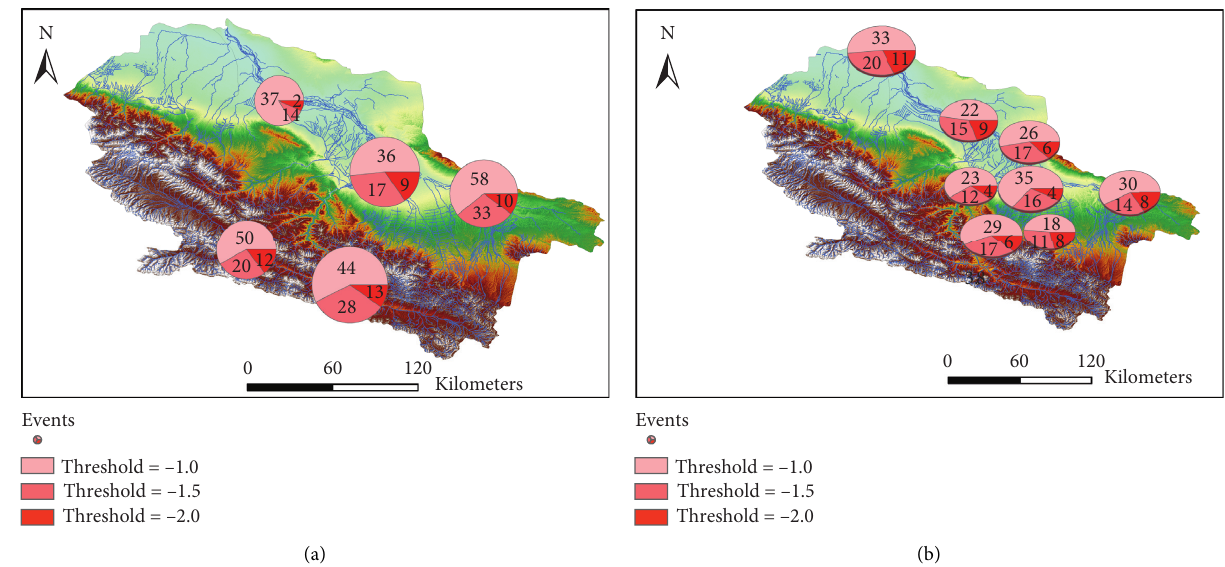
Figure 5: Spatial distribution of MD (SPI-1) and HD (SDI-1) events in the UHRB and